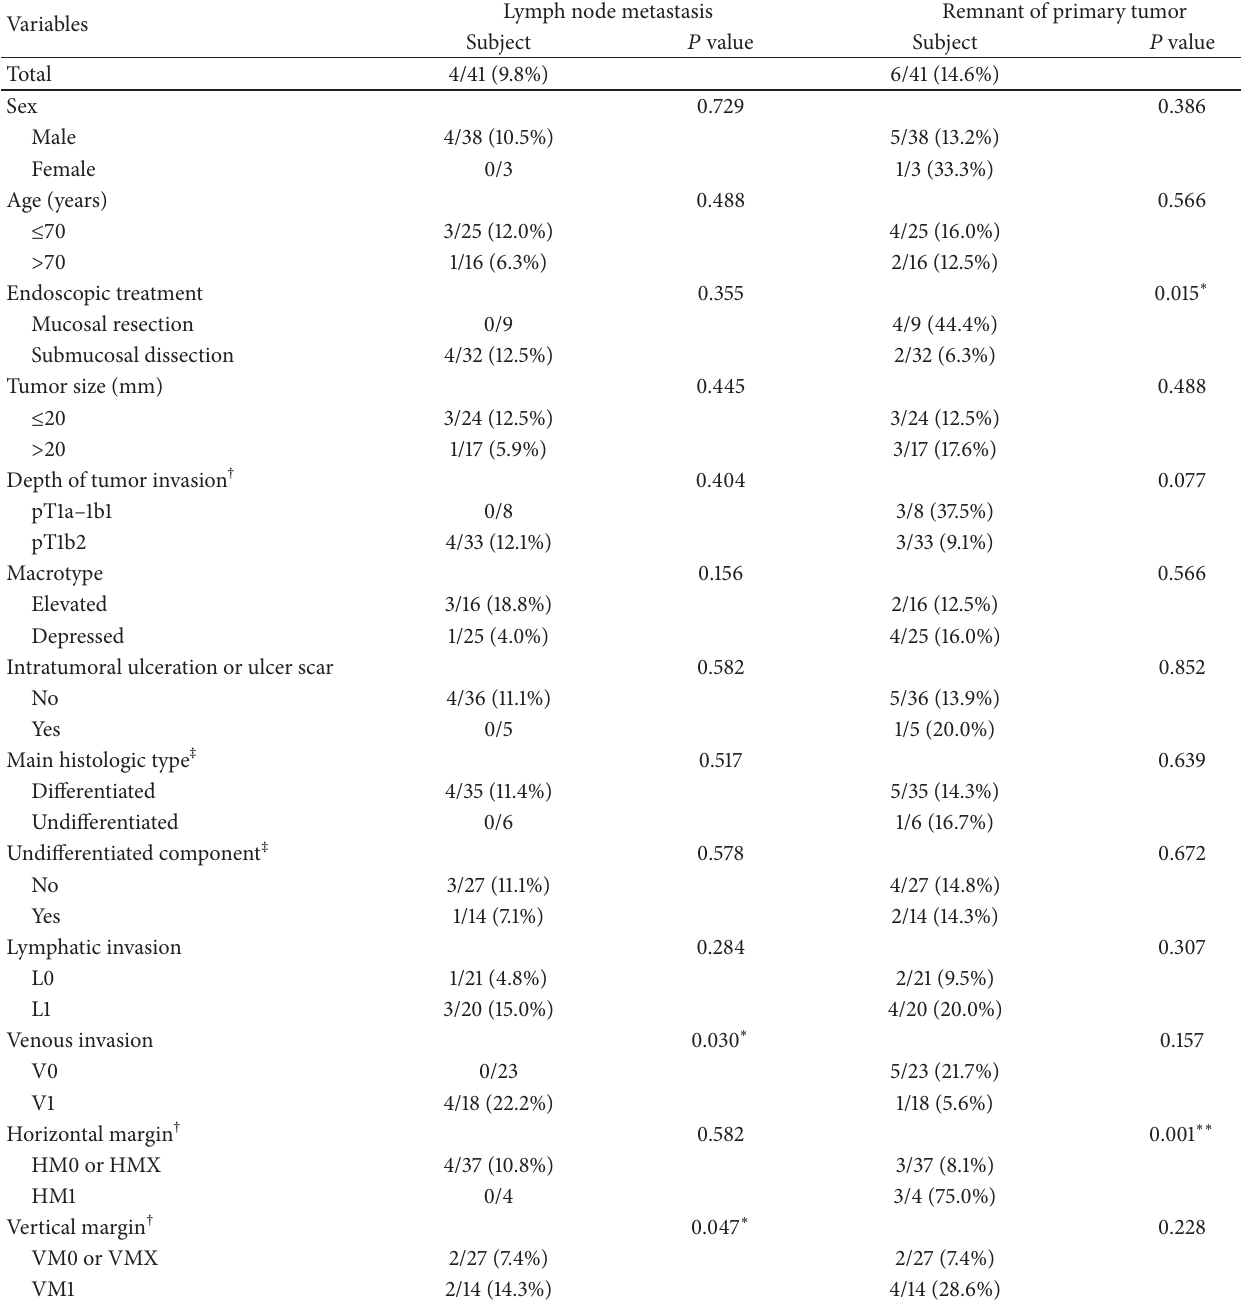
Table 2: Results of univariate analyses showing relationships among clinicopathological characteristics of specimens.